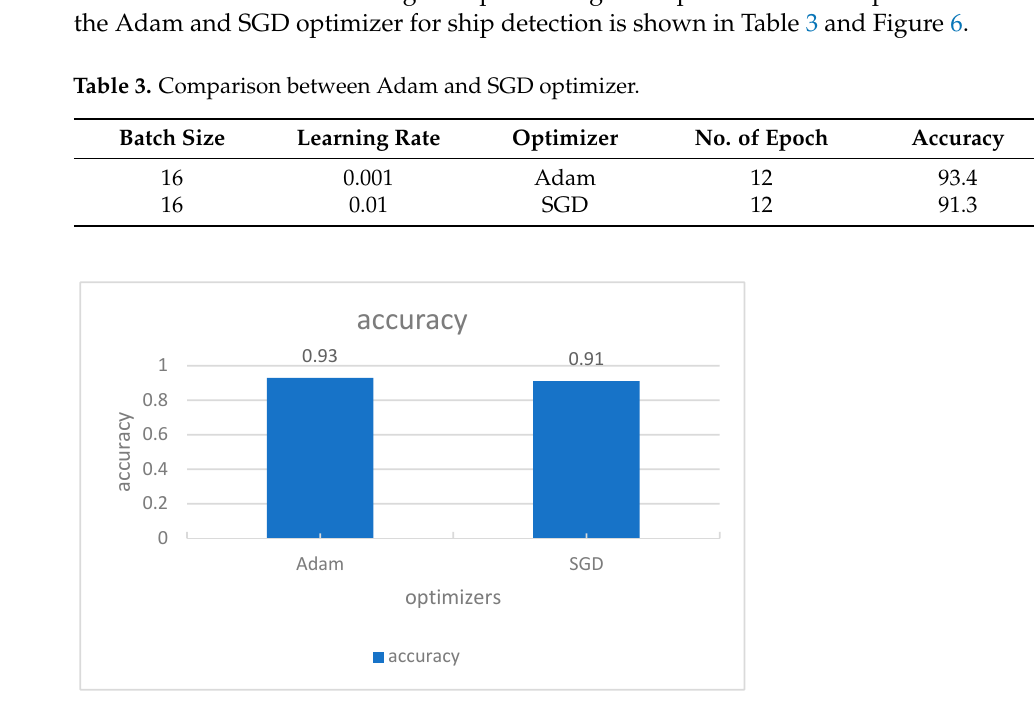
Table 2. Hyperparameters for the ship detection model .